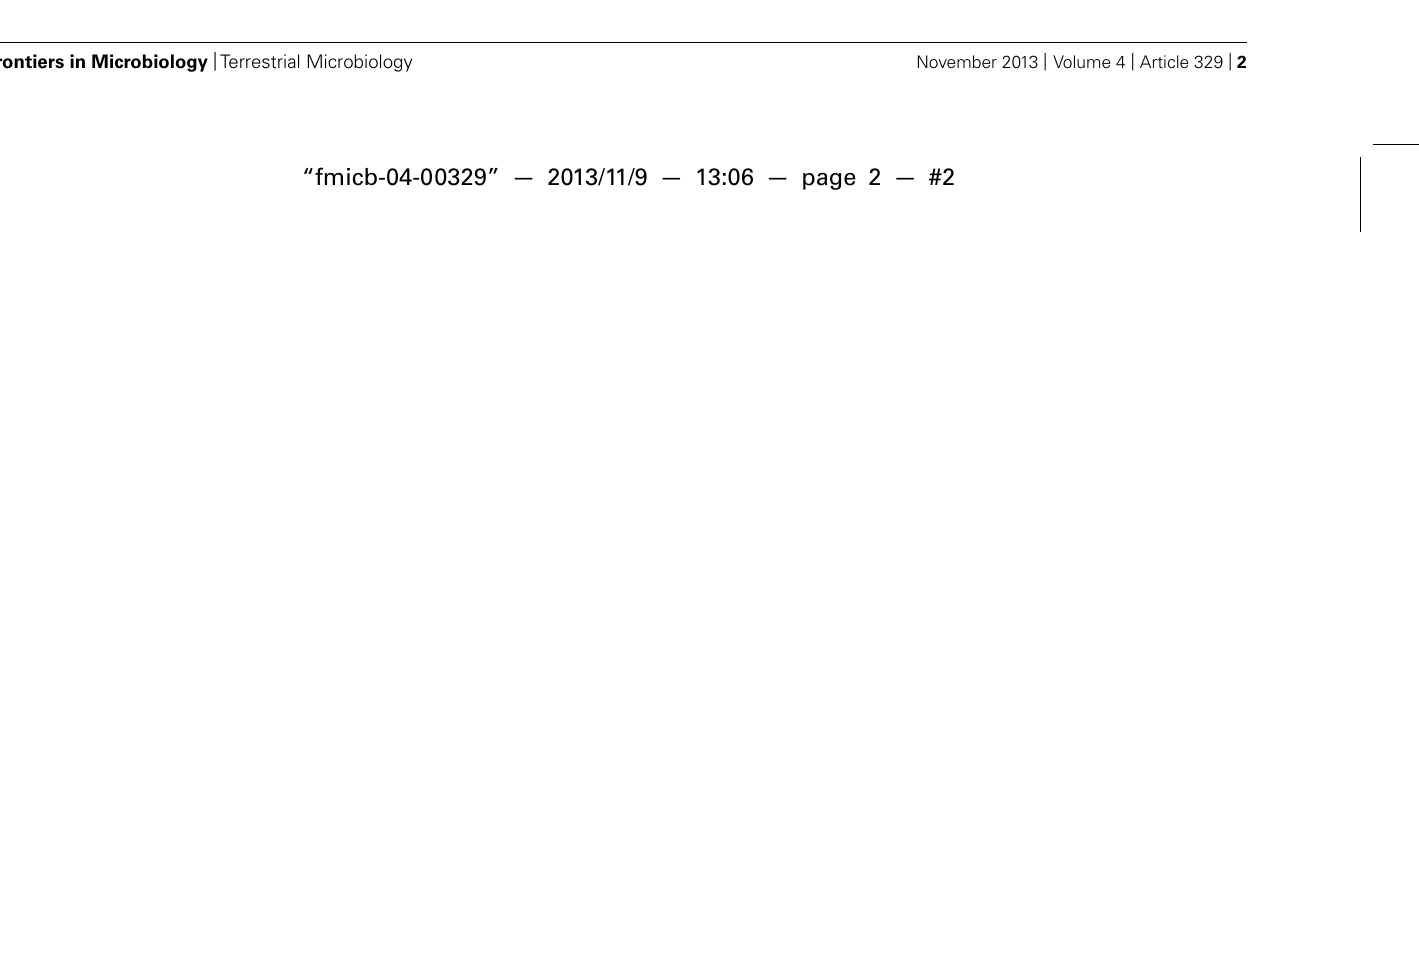
Frontiers in Microbiology |Terrestrial